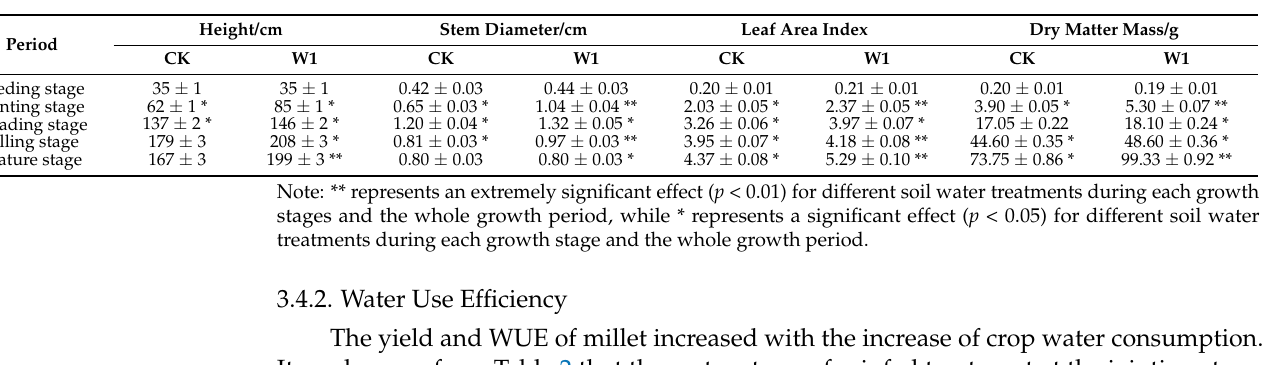
Table 1. Growth indicators of millet at individual growth stages under different